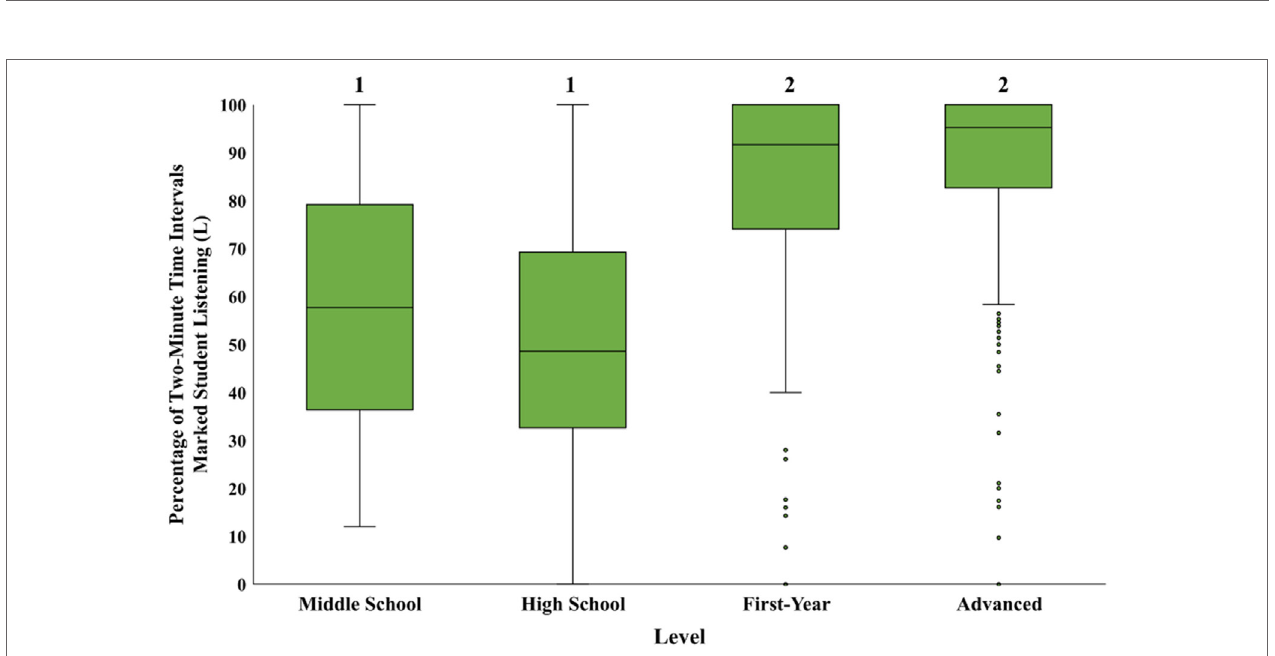
FigUre 7 | Comparison of the relative frequency of Classroom Observation Protocol for Undergraduate STEM code Student Listening (L) for middle school, high school, first-year university, and advanced university classes. Box-and-whisker plots showing the median and variation between the four instructional levels. The line in the middle of the box represents the median percentage of 2-min time intervals for the class sessions in each level. Boxes represent the interquartile range, whiskers represent 1.5 times the interquartile range, and data points not included in 1.5 times the interquartile range are shown with dots. Levels labeled with different numbers indicate a significant difference between mean ranks by a post hoc Dunn’s pairwise comparison (Kruskal–Wallis Test, χ 2 = 137.37, df = 3, N = 482, p < 0.001; Dunn’s pairwise comparisons, p < 0.001 for levels labeled with different numbers).